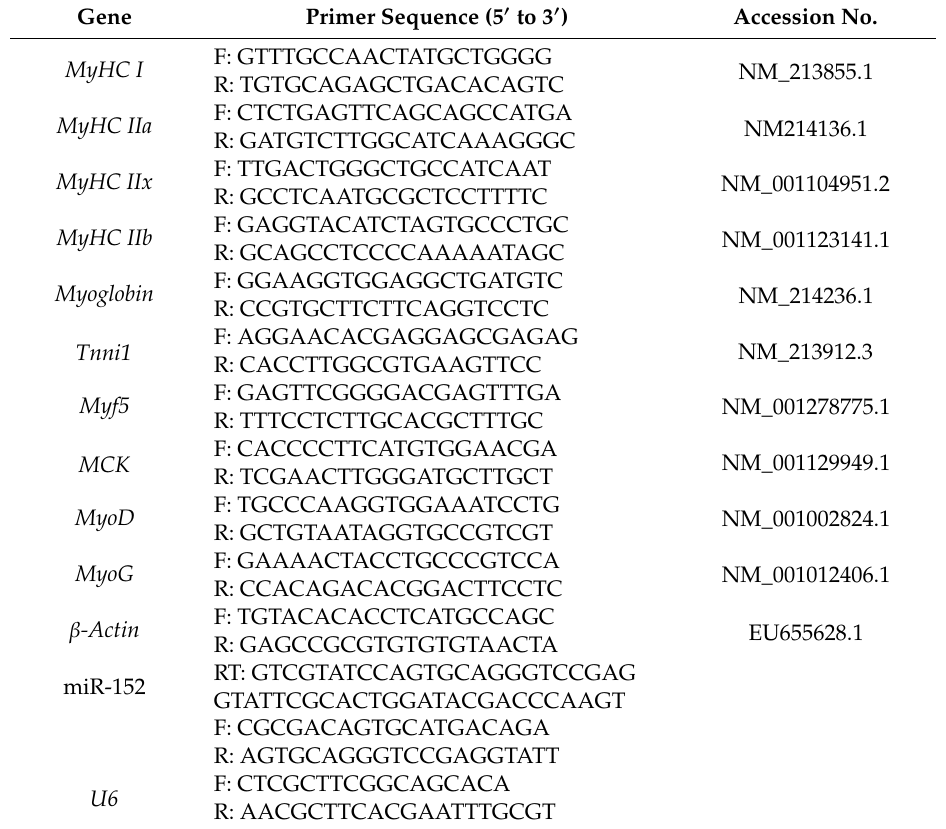
Table 1. Primers for